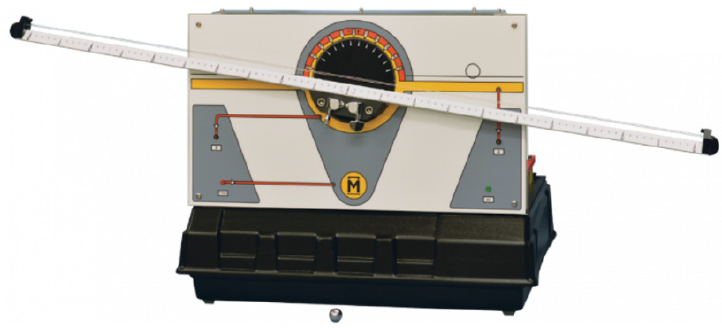
Figure 1. The ball and beam process used as a case study in this research [25].